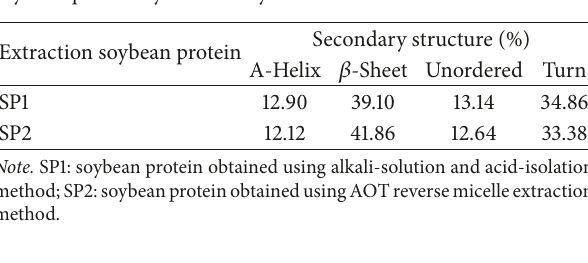
Table 4: Content of the secondary structure in different varieties of soybean protein by FTIR